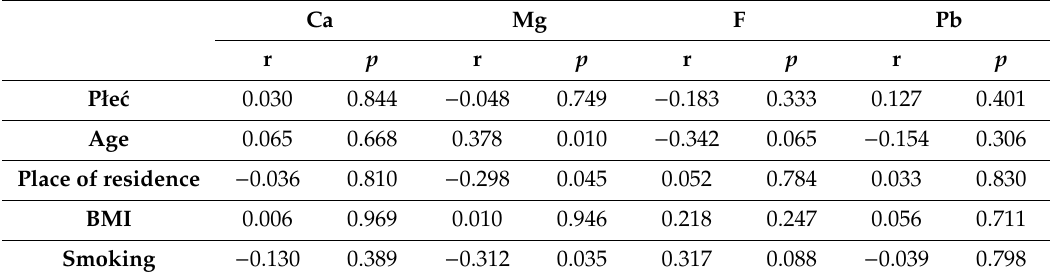
Table 3. Analysis of the relationship between the concentration levels of selected elements in the infrapatellar fat pad and selected biological and environmental